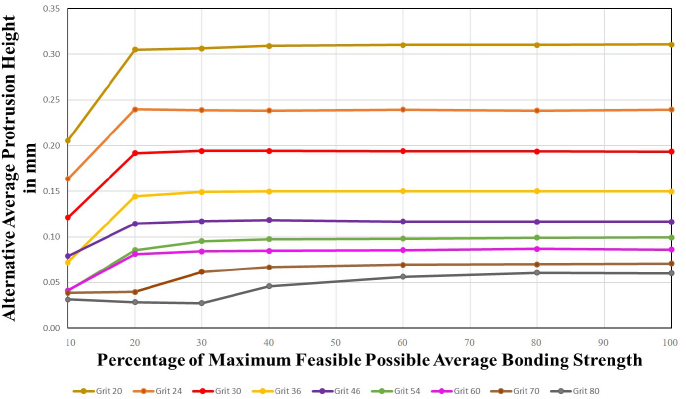
Figure 23. Alternative average protrusion height in comparison to the percentage of maximum feasible average bonding